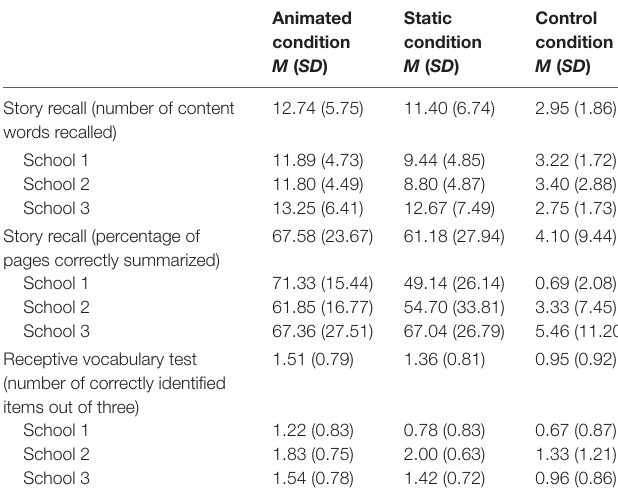
TABLE 2 | Descriptive statistics on the outcome measures of story retelling and receptive vocabulary for each condition.